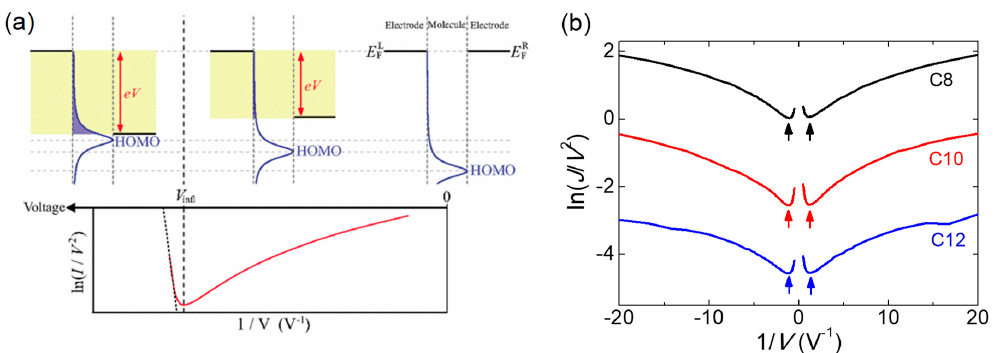
Figure 5. ( a ) Illustration of the inflection behavior in the FN curve and corresponding energy band diagrams. The inflection voltage V infl (vertically dashed line) in the FN curve denotes the transition voltage. Reproduced from Ref. [29], with permission from American Physical Society. ( b ) Representative TVS analysis of C8, C10 and C12 junctions. Each arrow indicates the transition voltage.